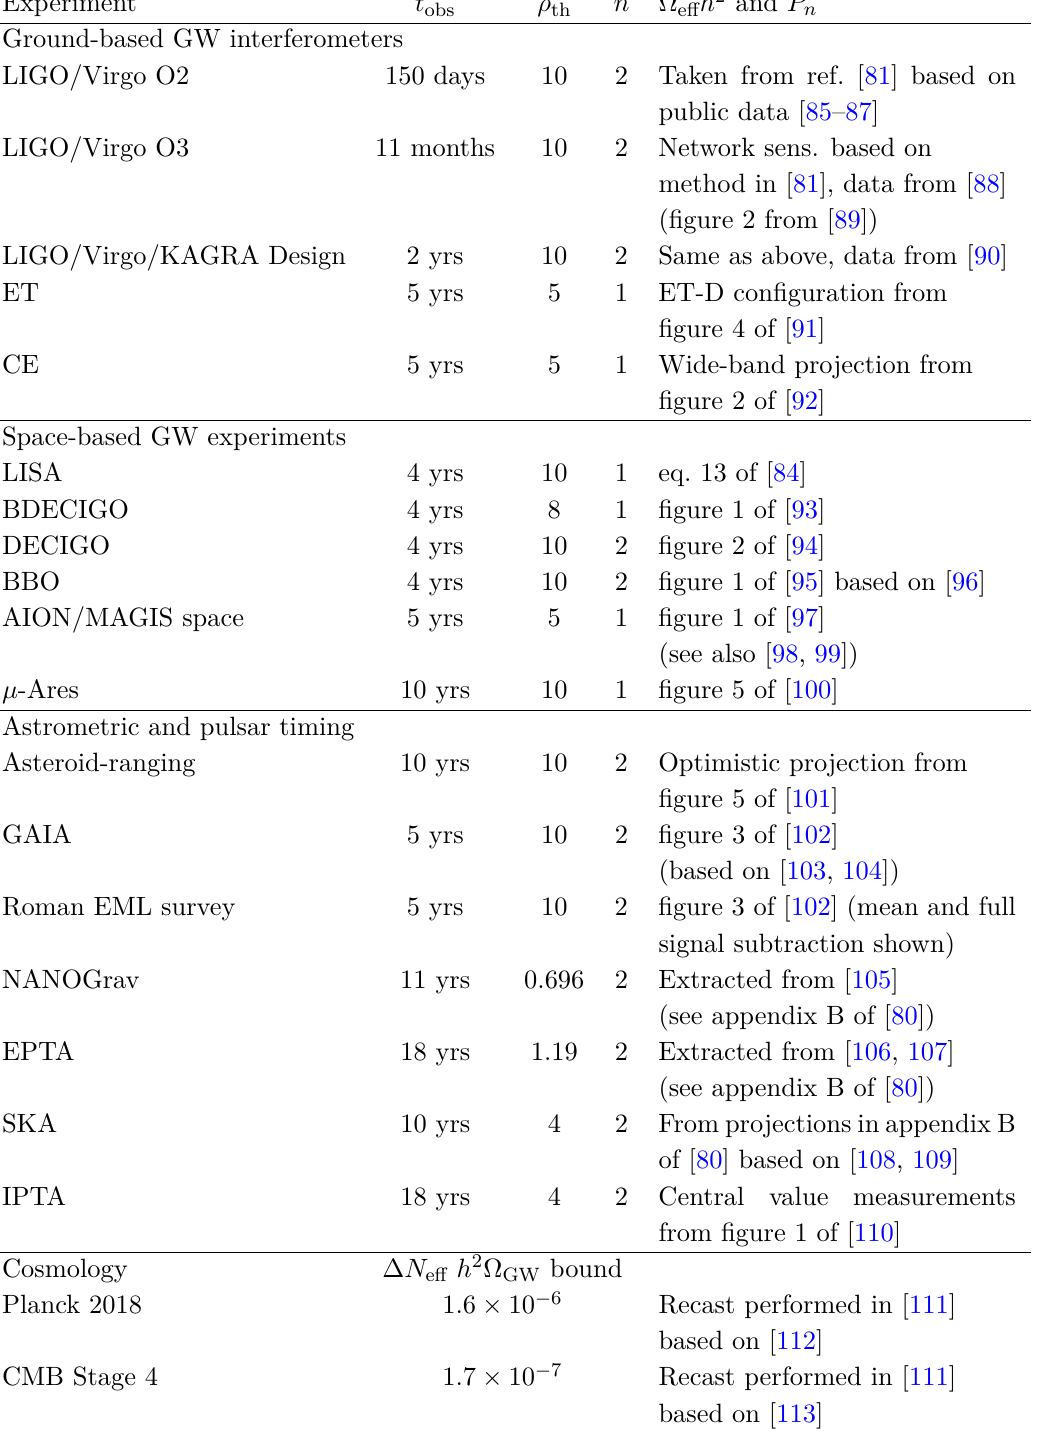
Table 2 . Summary of the experimental noise curves that enter figure 11 and the sensitivity projec- tions in figure 2. The ∆ N eff bound is a constraint based on the total energy density in GWs rather than an amplitude in a given frequency